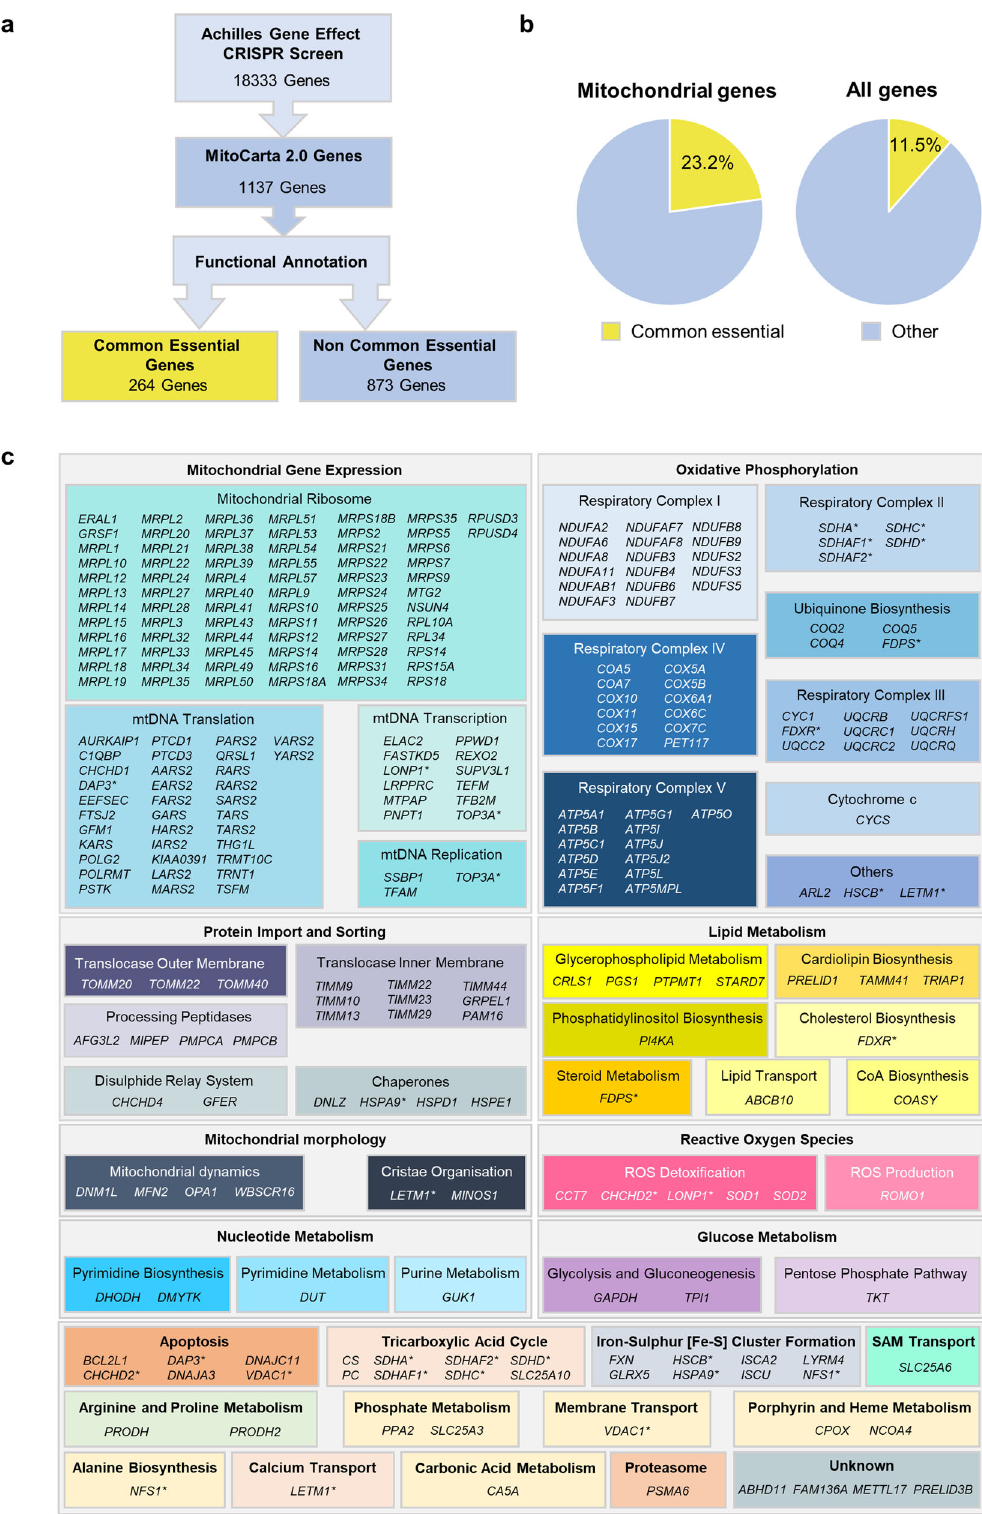
COMMUNICATIONS BIOLOGY| (2021) 4:615